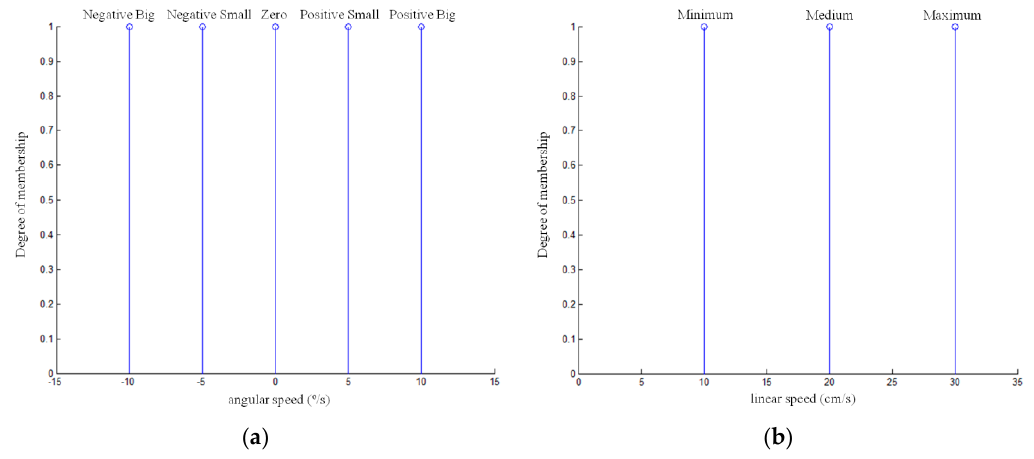
Figure 12. Fuzzy sets for the output variables: ( a ) angular speed and ( b ) linear speed.